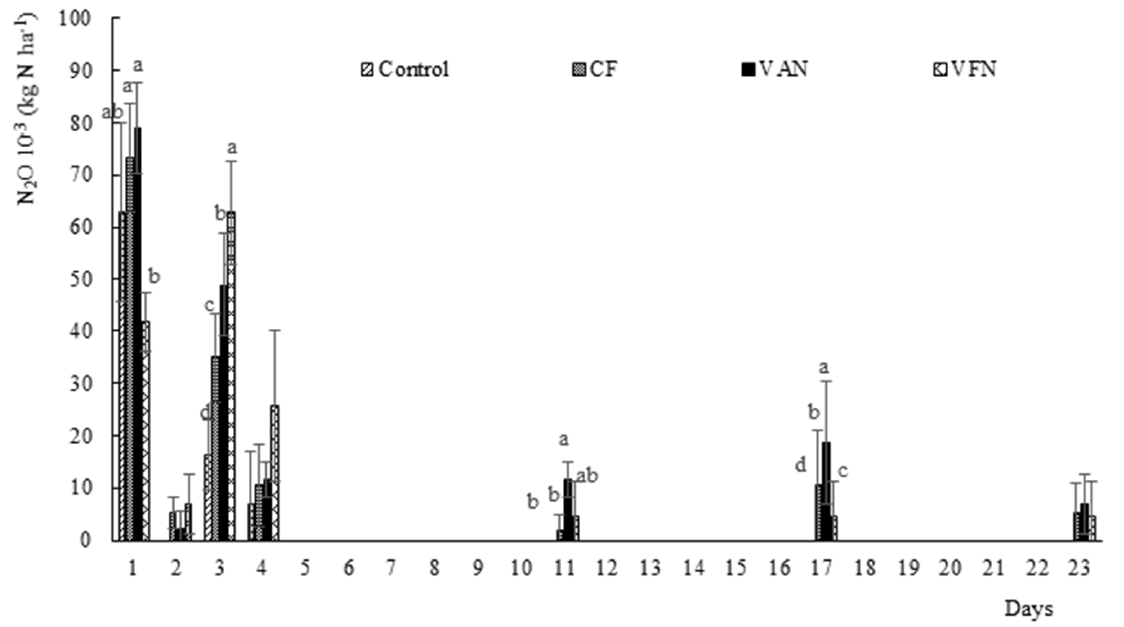
Figure 4. N 2 O emission dynamics (N 2 O 10 − 3 kg N ha − 1 ) for barley in season 2018/2019. Different letters indicate significant difference, according to Dunn’s post-hoc test ( p < 0.05), between treat- ments.